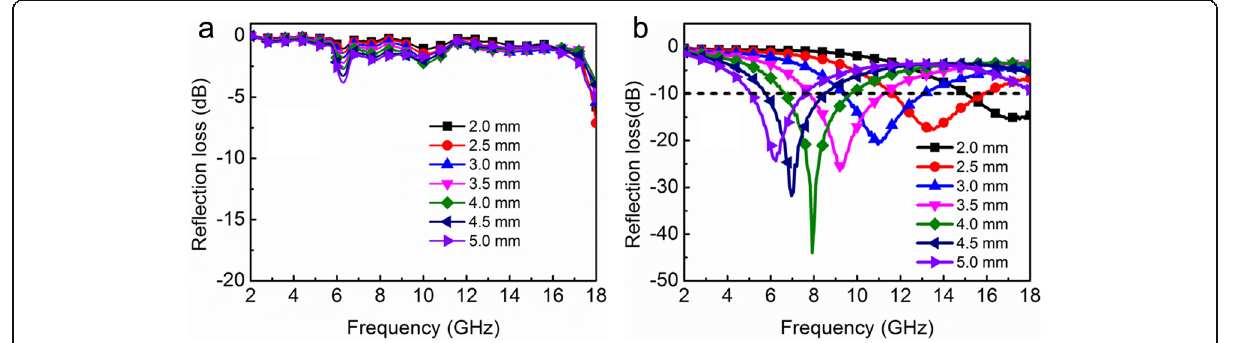
Fig. 6 Reflection loss curves of a CoFe 2 O 4 and b CoFe@C at different thicknesses